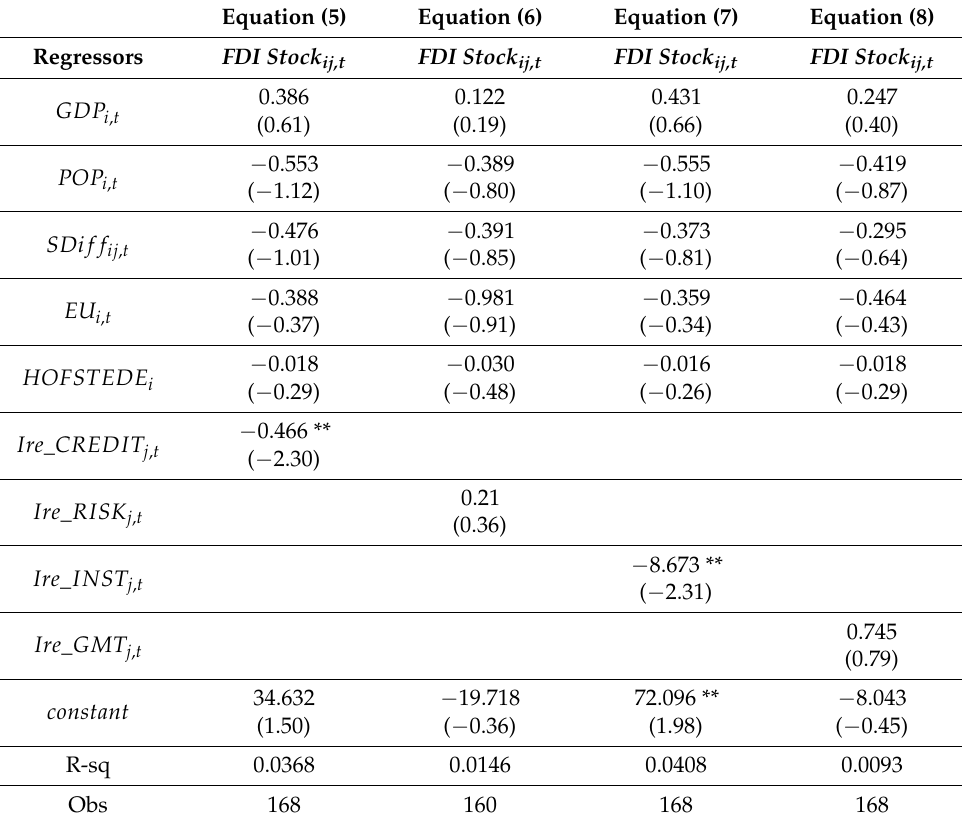
Robust t-statistics reported in parentheses. ** Significant at the 5 percent